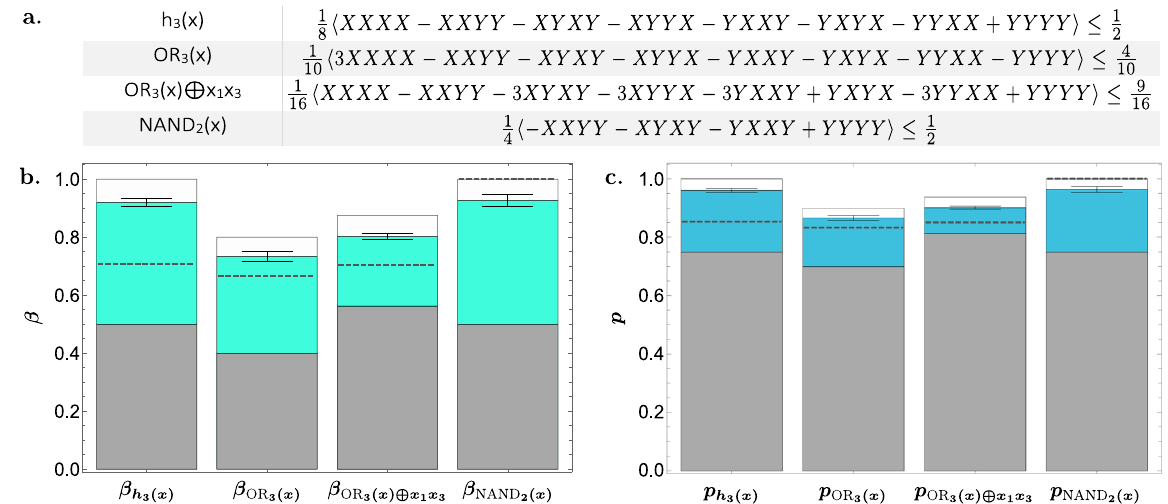
Fig. 4 Results of computation. a . Overview of the tested multipartite Bell inequalities with their corresponding Boolean functions. b – c . Classical, quantum, and experimentally obtained bounds for computing Boolean functions shown in the panels below. For both the bounds in Fig. 4b. and the probabilities Fig. 4c. the grey area of the bars indicate the regions completely obtainable with linear operations on classical resources. The coloured regions with the measurement points (error bars indicate the standard deviation) on top demonstrate that : 29 σ , β : 19 σ , β : 17 σ and, β : 21 σ ; showing that the correct these limits have been surpassed in each case by β h OR 3 ð x Þ OR 3 ð x Þ(cid:5) x 1 x 3 NAND 2 ð x Þ 3 ð x Þ computation of the non-linear Boolean function is more probable with quantum resources. The underlying white bars indicate the optimal quantum limits for 4 qubit measurements, while the grey dashed lines mark the quantum bound for three qubits, hence we see that with increased entangled resources the limit moves away form the classical bound unless it is already